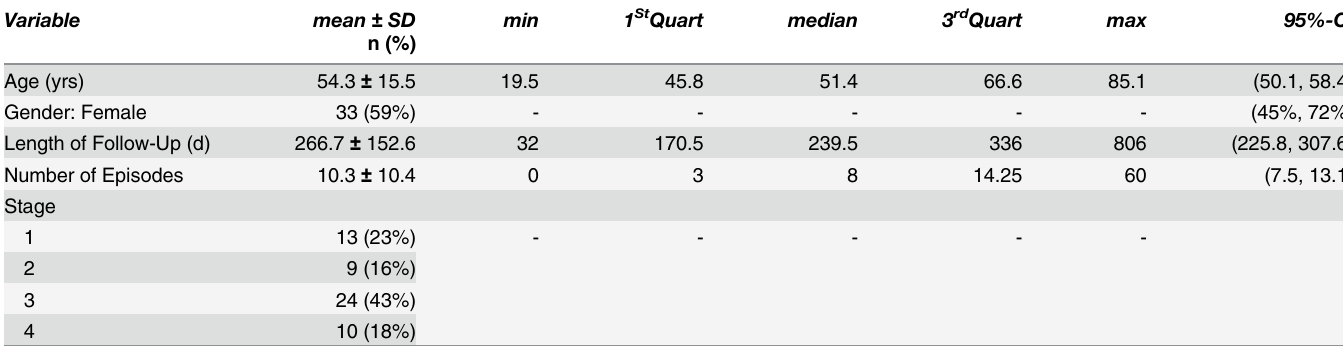
Table 1. Baseline characteristics of the study population (n = 56).